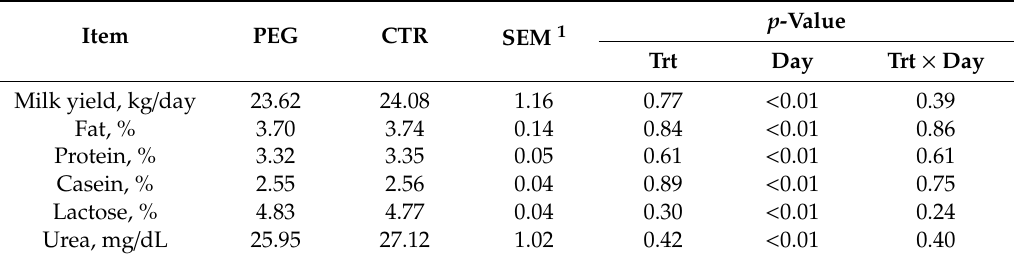
Table 2. E ff ect of Pegbovigrastim injections to Simmental dairy cows during the fresh period (from 1 to 30 days in lactation) on milk yield and